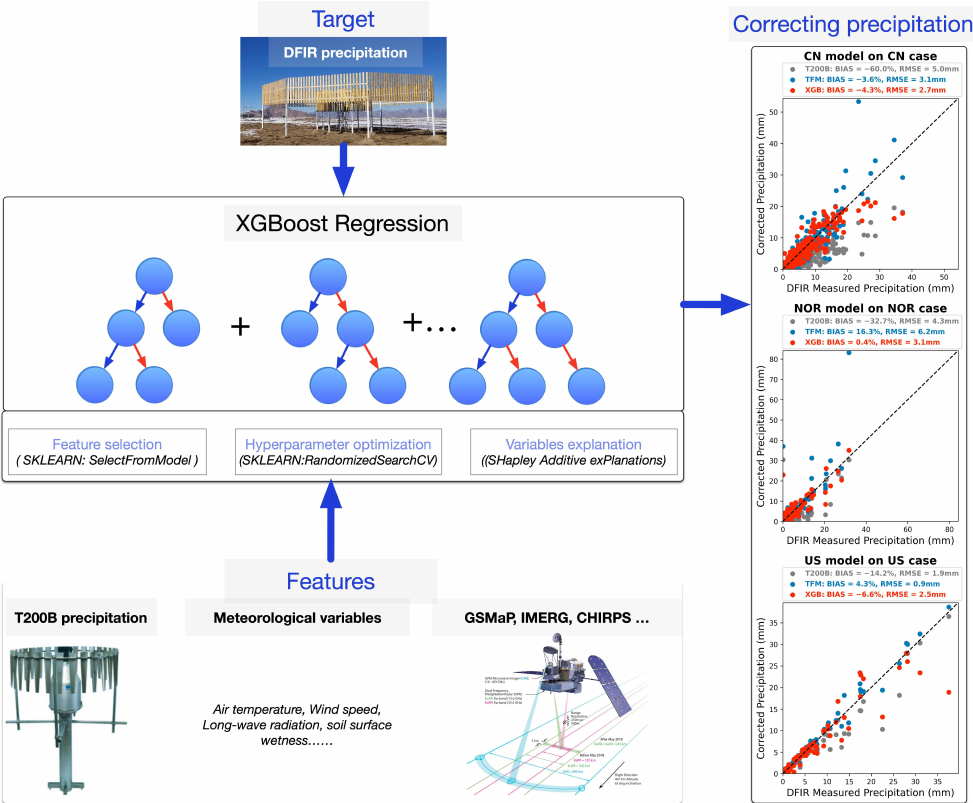
Figure 2. The methodology of the XGBoost regression-based precipitation correction. The features include the T200 precipitation, remote sensing precipitation, and other meteorological variables. The target is the DFIR precipitation. After feature selection and hyperparameter optimization, the trained XGB model was used in correcting precipitations. The photo of the satellite is from the NASA GPM website (https://gpm.nasa.gov/missions/GPM, accessed on 2 March